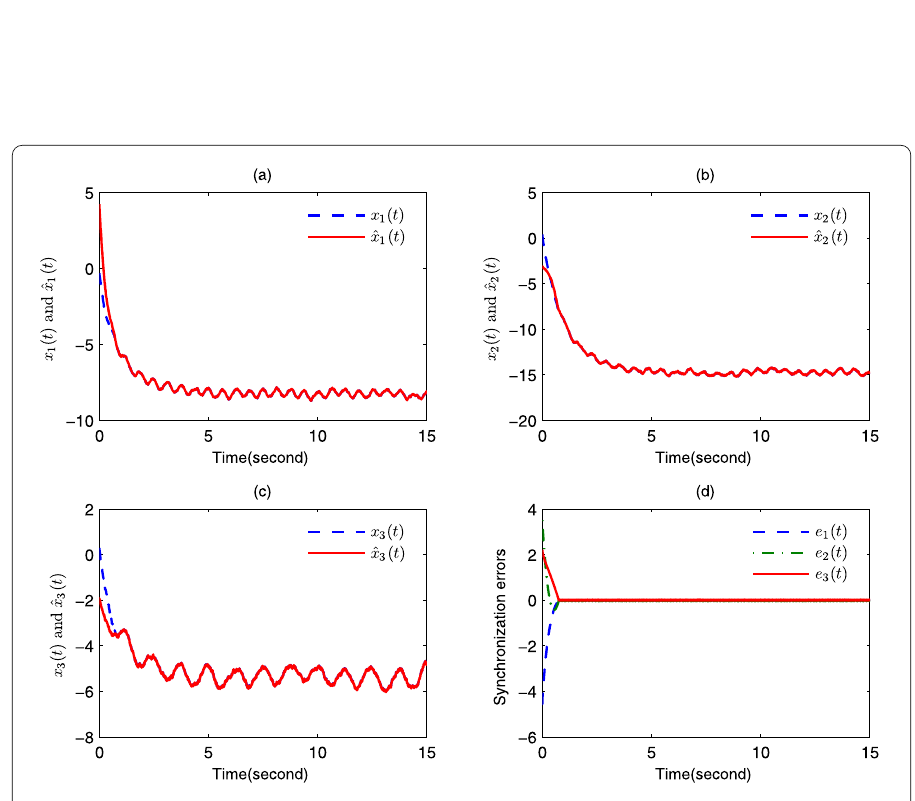
Figure 4 Simulation results when u ( t ) = –[2sin(10 t ) + 15rand( t ),2cos(10 t ) + 20rand( t ),2sin(5 t ) + 18rand( t )] T in ( a ) x 1 ( t ) and ˆ x 1 ( t ); ( b ) x 2 ( t ) and ˆ x 2 ( t ); ( c ) x 3 ( t ) and ˆ x 3 ( t ); ( d ) synchronization